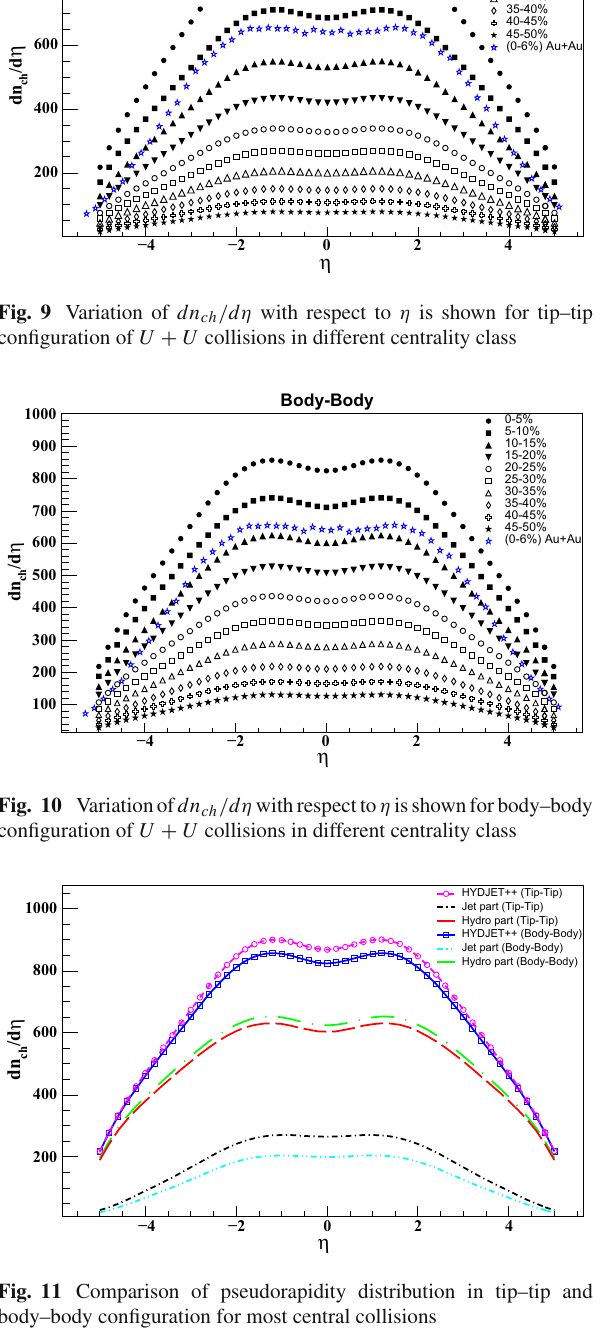
have compared HYDJET++ results with the published exper-